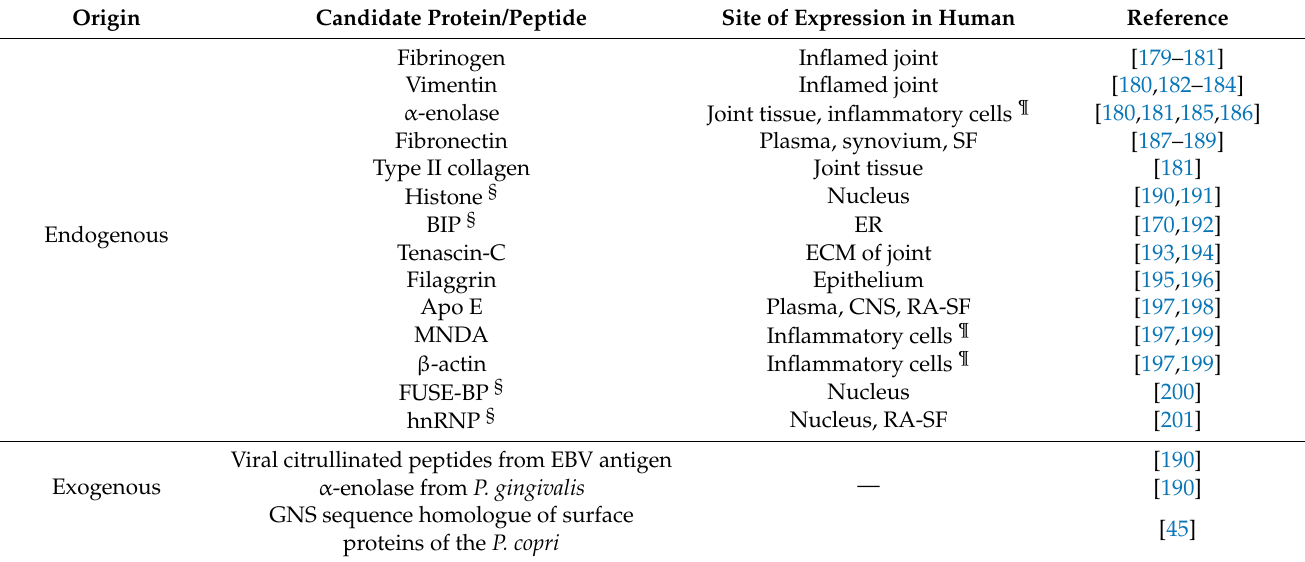
Table 4. Candidate proteins and peptides as targets of anti-citrullinated protein/peptide antibodies (ACPAs).